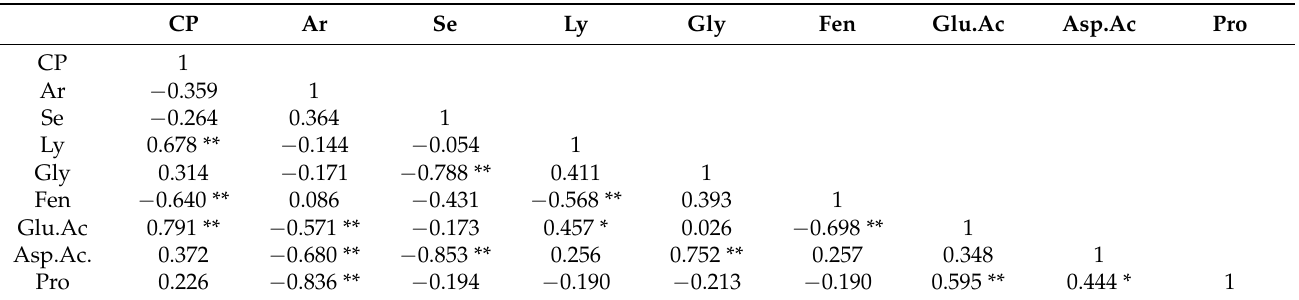
Table 6. Pearson correlation coefficient matrix for crude protein and amino acid content in hazelnut samples.